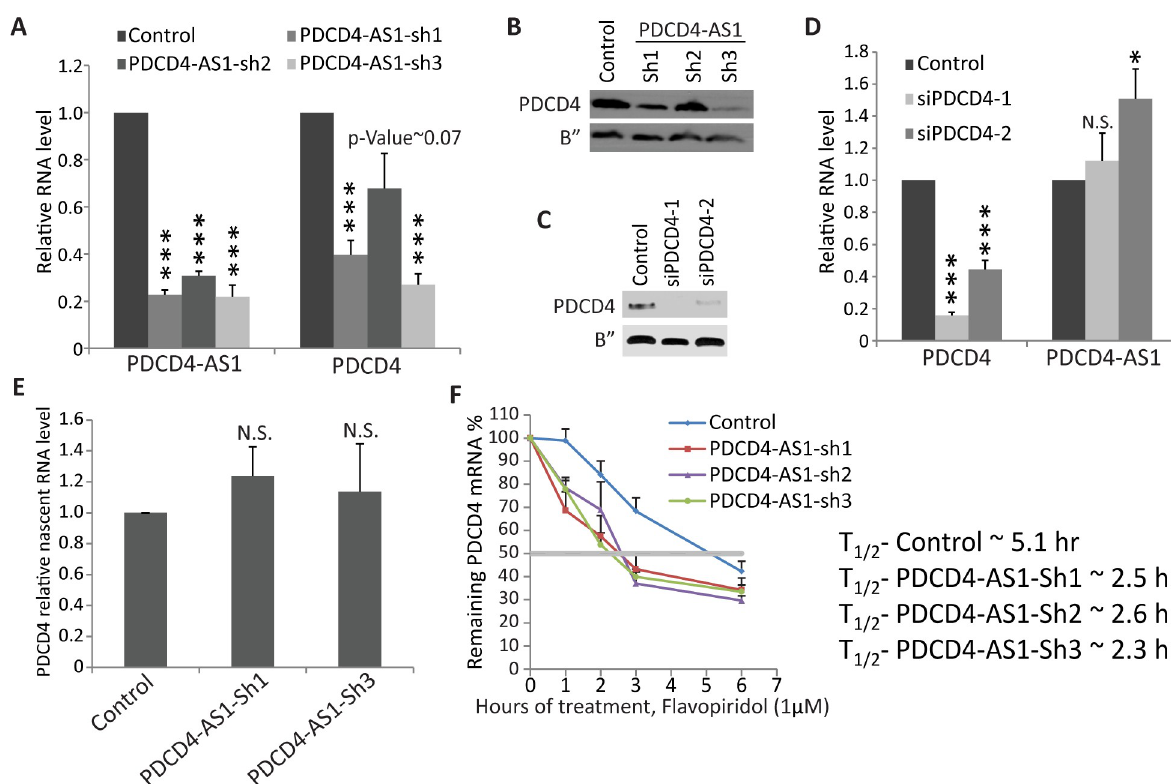
Fig 4. PDCD4-AS1 promotes the stability of PDCD4 mRNA. A) PDCD4 and PDCD4-AS1 RNA level measured by RT-qPCR in control and PDCD4-AS1 -depleted M1 cells. B) PDCD4 protein level in control and PDCD4-AS1 -depleted M1 cells. C) PDCD4 and PDCD4-AS1 RNA level measured by qPCR in control and PDCD4 -depleted M1 cells. D) PDCD4 protein level in control and PDCD4 -depleted M1 cells. E) Nascent RNA assay in control and PDCD4-AS1 -depleted M1 cells. F) RT-qPCR to quantify PDCD4 mRNA stability assay using RNA from control and PDCD4-AS1 -depleted M1 cells treated with Flavopiridol (1M) for indicated time points (0, 1,2,3 and 6 hrs). Error bars in (A, D, E & F) represent mean ± SEM of N � 3 independent experiments (biological replicates). � P < 0.05, �� P < 0.01 and ��� P < 0.001 using Student’s t test. N.S. represents not significant